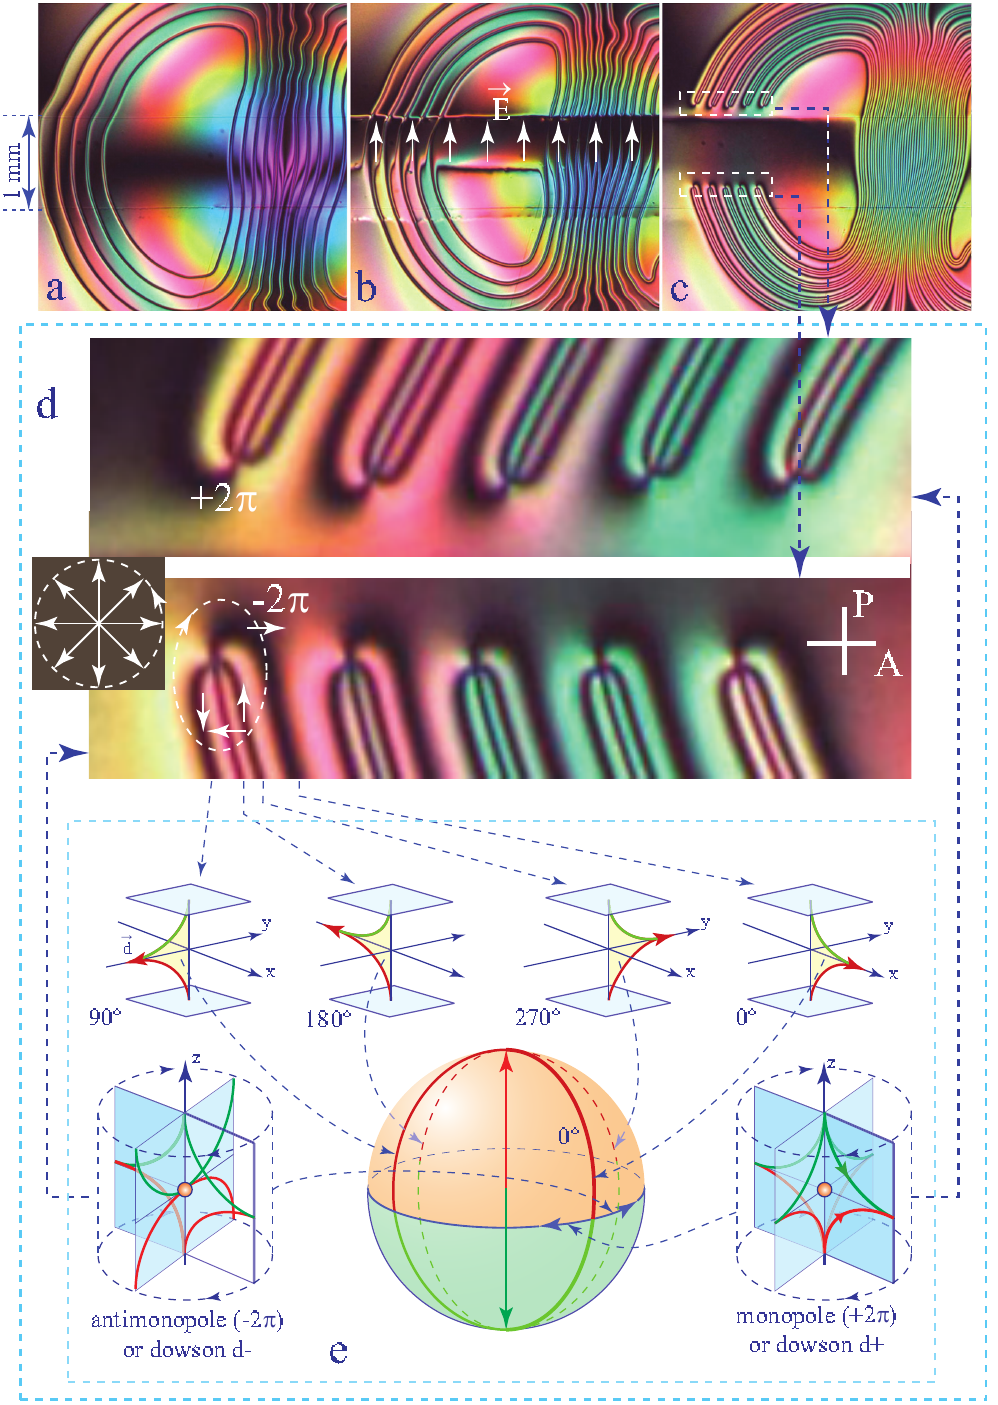
Figure 14. Generation of dowsons equivalent to nematic monopoles. ( a ) Wound up dowser texture made of 2 π -walls. ( b ) Thinning of the 2 π -walls in a strong electric fields leads to their breaking. ( c ) Two rows of dowsons d+ and d- generated by breaking of the 2 π -walls. ( d ) Detailed views of the dowser field. ( e ) Mapping of the director field on the space of the nematic order